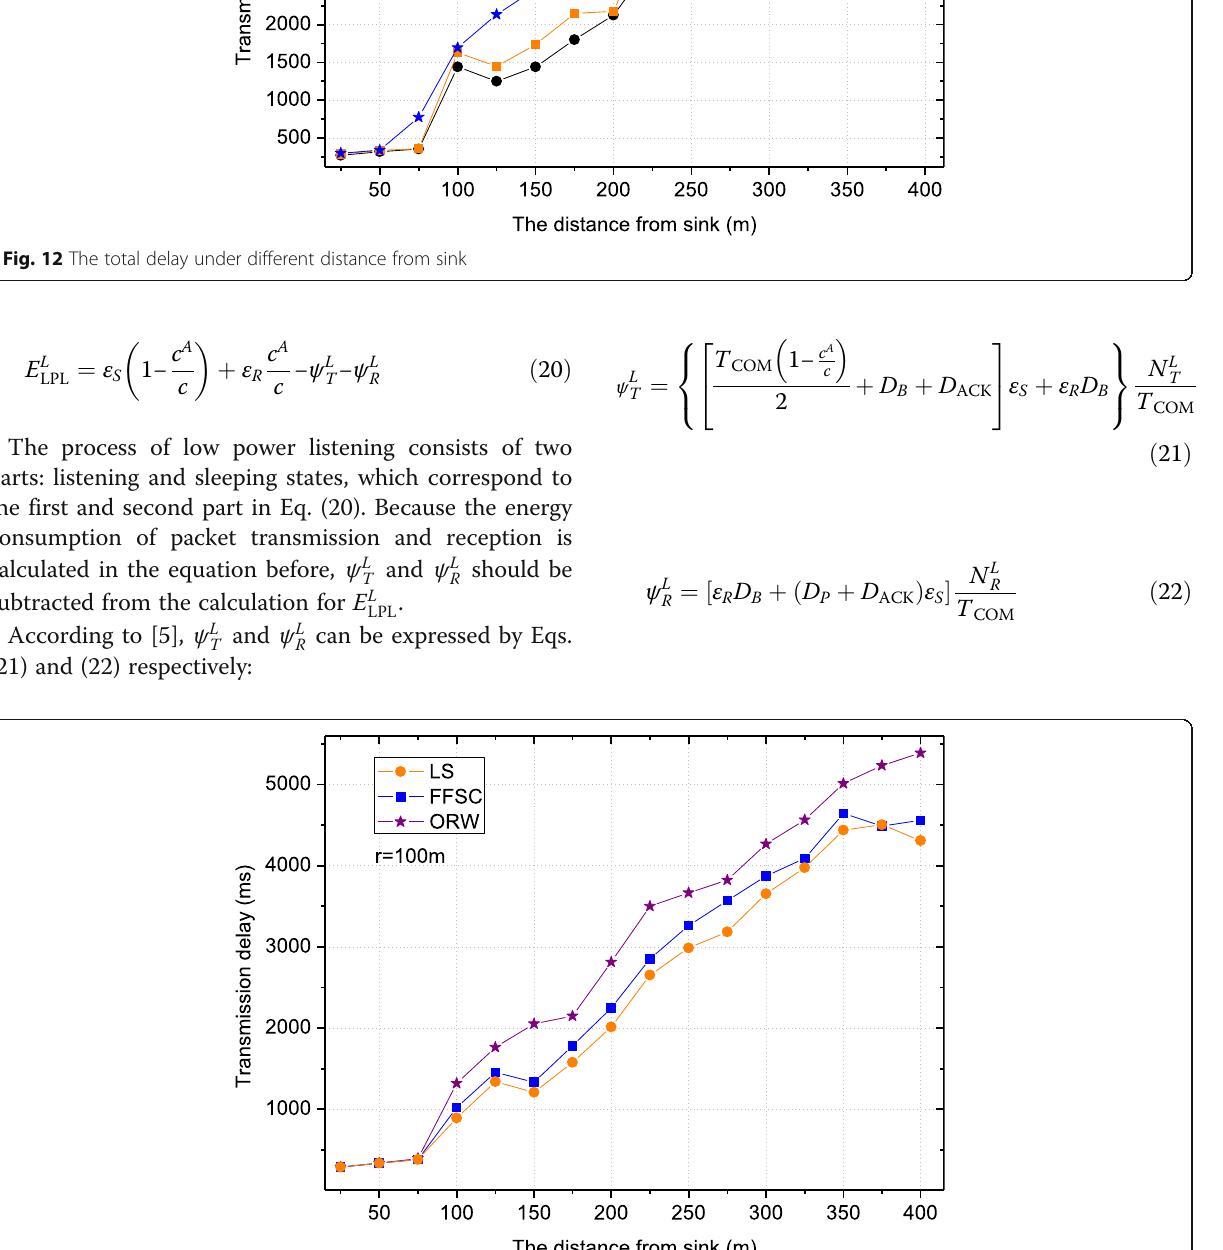
Fig. 12 The total delay under different distance from sink